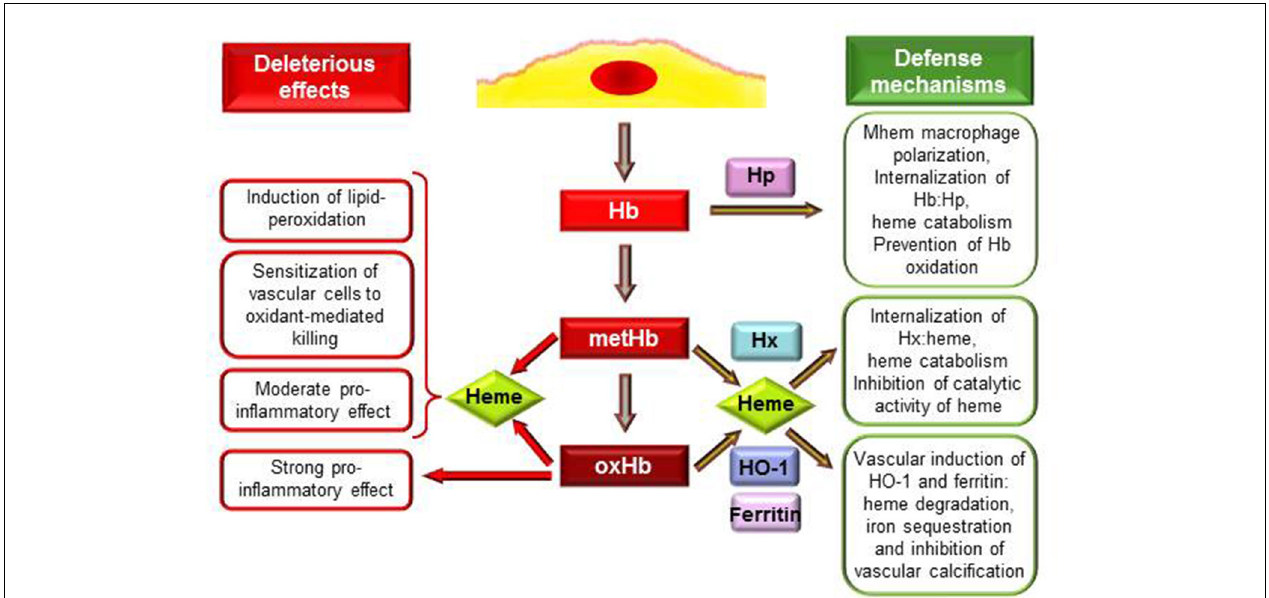
FIGURE 1 | Deleterious effects and defense mechanisms triggered by extracellular hemoglobin and its oxidation products upon intraplaque hemorrhage. Interactions between RBCs and plaque lipids lead to lysis of erythrocytes and release of Hb. Extracellular Hb by reacting with plaque lipids undergo rapid oxidation to metHb and oxHb. MetHb and oxHb release their heme moieties that possess pro-oxidant and pro-inflammatory properties. OxHb is a strong pro-inflammatory agonist which effect is independent of heme release. As an atheroprotective mechanism in response to Hb stress Mhem macrophages polarization occurs. Hp binding Hb but not oxHb attenuates Hb oxidation and their uptake by Mhem macrophages results in